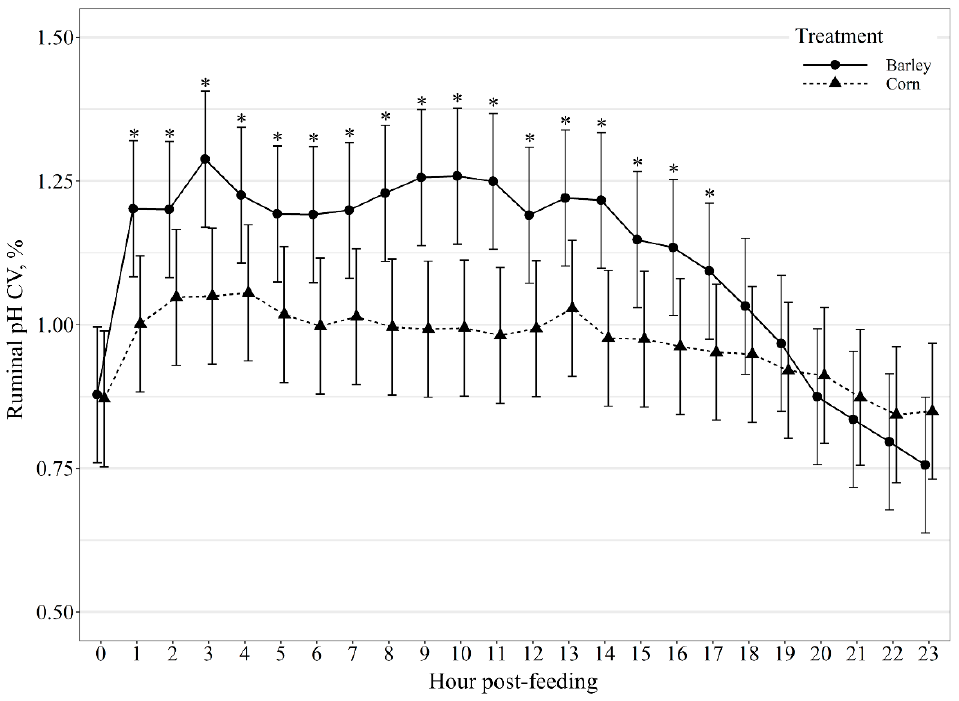
Figure 3. Diurnal pH coefficient of variation (CV, %) patterns of beef steers fed once daily (0800) barley- or corn-based feedlot diets. Ruminal pH CV was influenced by diet × hour post-feeding interaction ( p < 0.01) and differences ( p ≤ 0.05) within hour post-feeding are denoted by *. Average hourly ruminal temperature exhibited a diet by hour post-feeding interaction ( p < 0.01; Figure 4), with corn-fed steers having greater ( p ≤ 0.01) ruminal temperature at 0, 1, and 23 h and tended ( p ≤ 0.10) to have greater ruminal temperature at 4, 18, 21 and 22 h post-feeding. Variation in ruminal temperature hour post-feeding also displayed a diet by hour post-feeding interaction ( p < 0.01; Figure 5), where corn-fed steers had greater ( p = 0.02) variation in ruminal temperature at 2 h post-feeding than barley-fed steers; however, barley-fed steers had greater ( p ≤ 0.02) variation in ruminal temperature than corn-fed steers at 3, 4, 5, 7, 8, 9, 10, 11, 15, 16, 17 and 18 h post-feeding. Ruminal pH post-intake event displayed a diet by minute post-intake event interaction ( p < 0.01; Figure 6); however, post hoc mean separation displayed no diet effects ( p ≥ 0.63) on ruminal pH within minute post-intake event. Similarly, ruminal temperature post-intake event also exhibited a diet by minute post-intake event interaction ( p < 0.01; Figure 7); however, post hoc means separation displayed no diet effects ( p ≥ 0.11) on ruminal temperature within minute post-intake